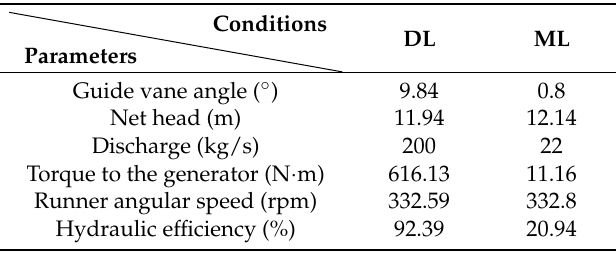
Table 1. Model testing parameters applied during steady-state measurements conducted under the designed load (DL) condition and the minimal load (ML) condition.